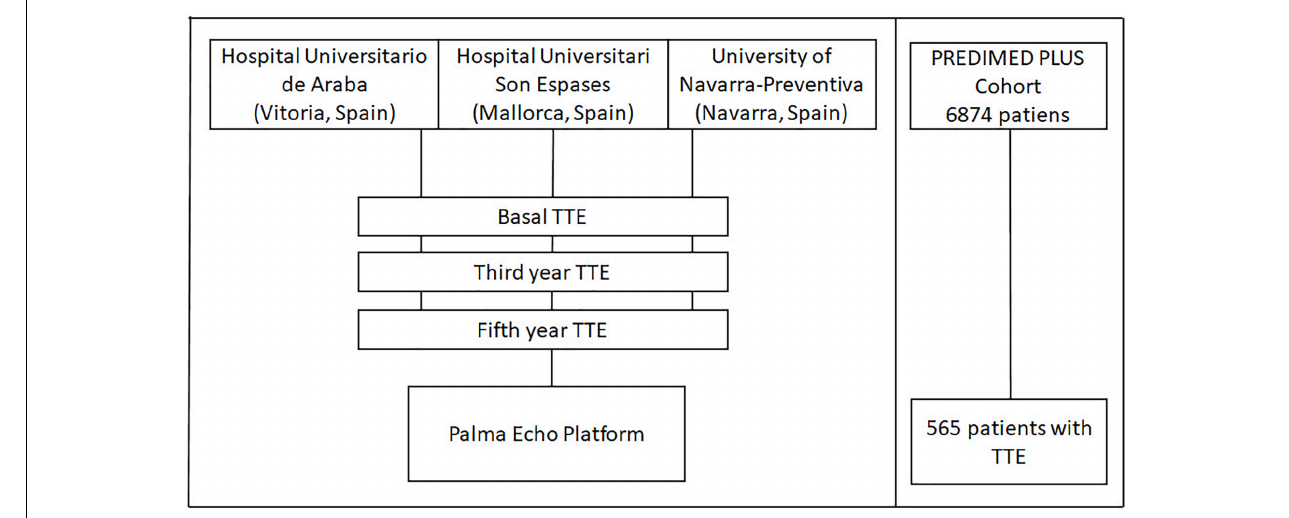
FIGURE 1 | Study outline. TTE, Transthoracic